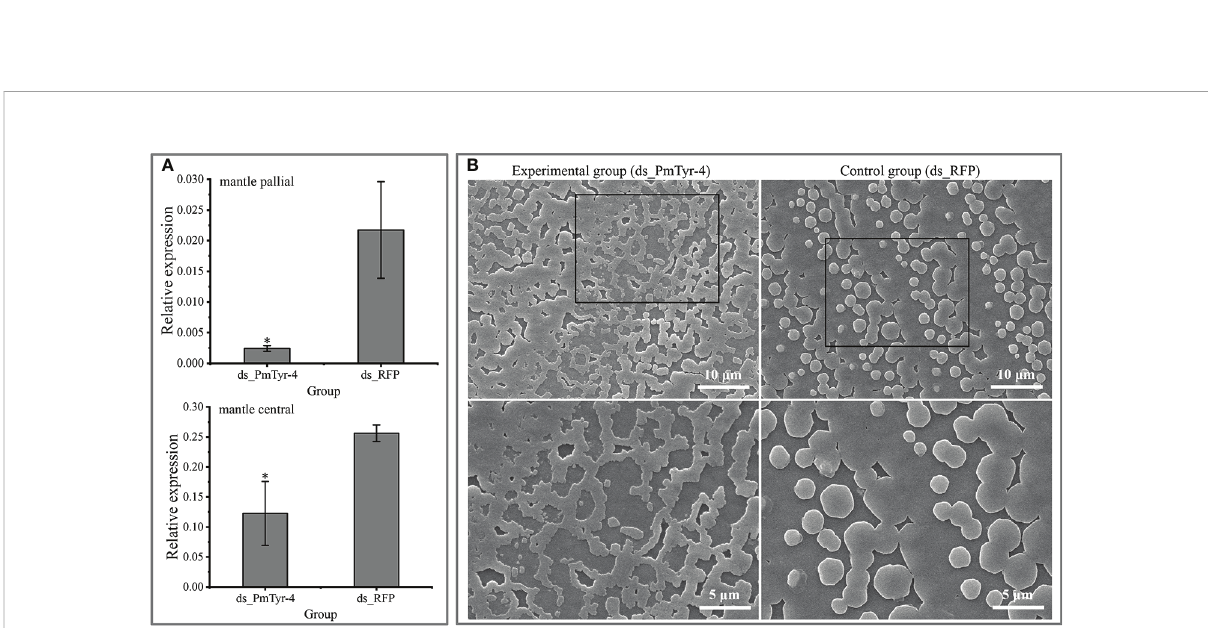
FIGURE 5 Effect of PmTyr-4 on nacre formation. (A) Expression levels of PmTyr-4 in MP and MC after RNAi. (B) Microstructure of nacre surfaces of the experimental and control groups. * indicates signi fi cant difference by T-test ( P<0.05 ). Error bars correspond to mean ± SD. The white line in the image indicates the scale.